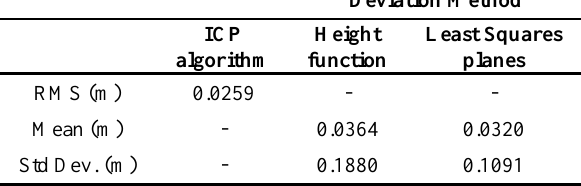
Table 2: Results of the ICP registration and the residual deviations of the point cloud comparison for the